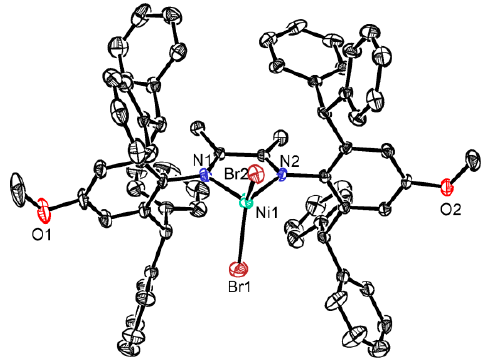
Figure 1. Molecular structure of complex 1a (thermal ellipsoids are shown at the 30% probability level). Hydrogen atoms have been omitted for clarity. Solvent molecule (CH 2 Cl 2 ) was also omitted.